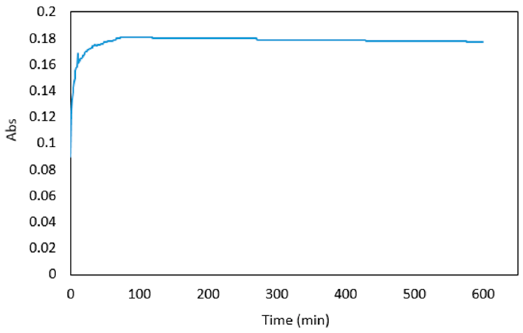
Figure 4. Absorbance of 1 µ g mL − 1 arsenic sample premixed with the reagents over 600 min.